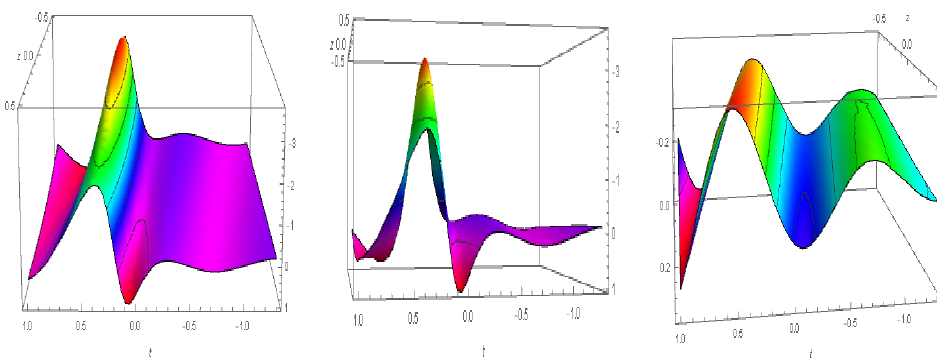
Figure 25. The KCR profiles of the solution ∆ 13 in Equation (49) are formed for values of b 2 = 1, b 1 = 3, a 2 = 0.1, µ = 2, g 0 = 3, b 3 = 2, b 4 = 5, c 2 = 4 and k 2 = 2. Three-dimensional graphs at (i) a 2 = − 5, (ii) a 2 = 1 and (iii) b 2 =